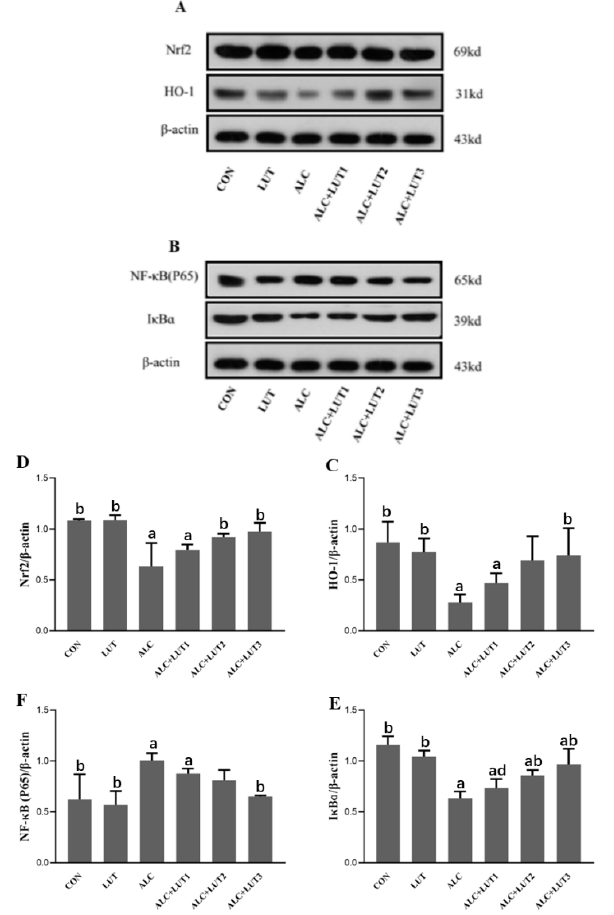
Figure 6. Changes in expression of proteins related to the nuclear factor kappa B (NF- κ B)/nuclear factor-erythroid factor 2-related factor 2 (Nrf2) pathway. ( A , B ) Effects of lutein on the expression of proteins in the NF- κ B and Nrf2 pathways in alcohol-treated rats. The protein levels of heme oxygenase-1 (HO-1) ( C ), Nrf2 ( D ), inhibitor of nuclear factor kappa B α (I κ B α ) ( E ), and NF- κ B (P65) ( F ). CON: control group; LUT: lutein alone supplement group; ALC: alcohol model group; ALC + LUT1: alcohol + low-dose lutein group; ALC + LUT2: alcohol + medium-dose lutein group; ALC + LUT3: alcohol + high-dose lutein group. a, vs. the control group, p < 0.05 (CON); b, vs. the alcohol group, p < 0.05 (ALC); d, vs. the ALC + LUT3 group, p < 0.05. (Values are expressed as mean ± SD; n = 3).